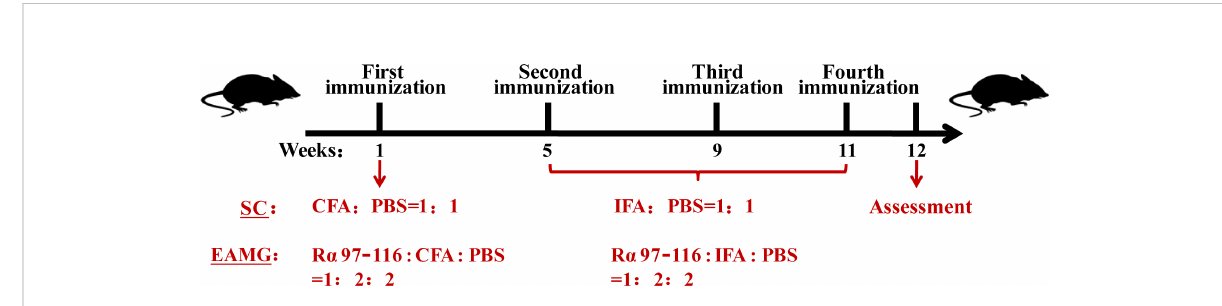
FIGURE 1 Animal modeling process. After 1 week of adaptive feeding, 51 female C56BL/6J mice were randomly divided into the normal control (NC) ( n = 6), solvent control (SC) ( n = 5), and experimental autoimmune myasthenia gravis (EAMG) ( n = 40) groups. The mice in the SC group and the EAMG group received the fi rst immunization in the fi rst week, the second immunization in the fi fth week, the third immunization in the ninth week, and the fourth immunization in the eleventh week. The EAMG model was assessed in the twelfth